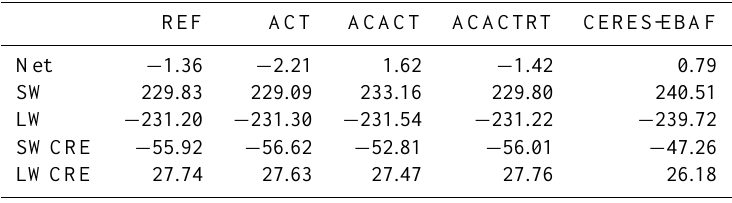
Table 4. Present-day global mean values in each model configuration for (from top to bottom) the net radiation balance, net shortwave (SW) radiation, net longwave (LW) radiation, SW cloud radiative effect (SWCRE) and LW cloud radiative effect (LWCRE) in Wm − 2 .